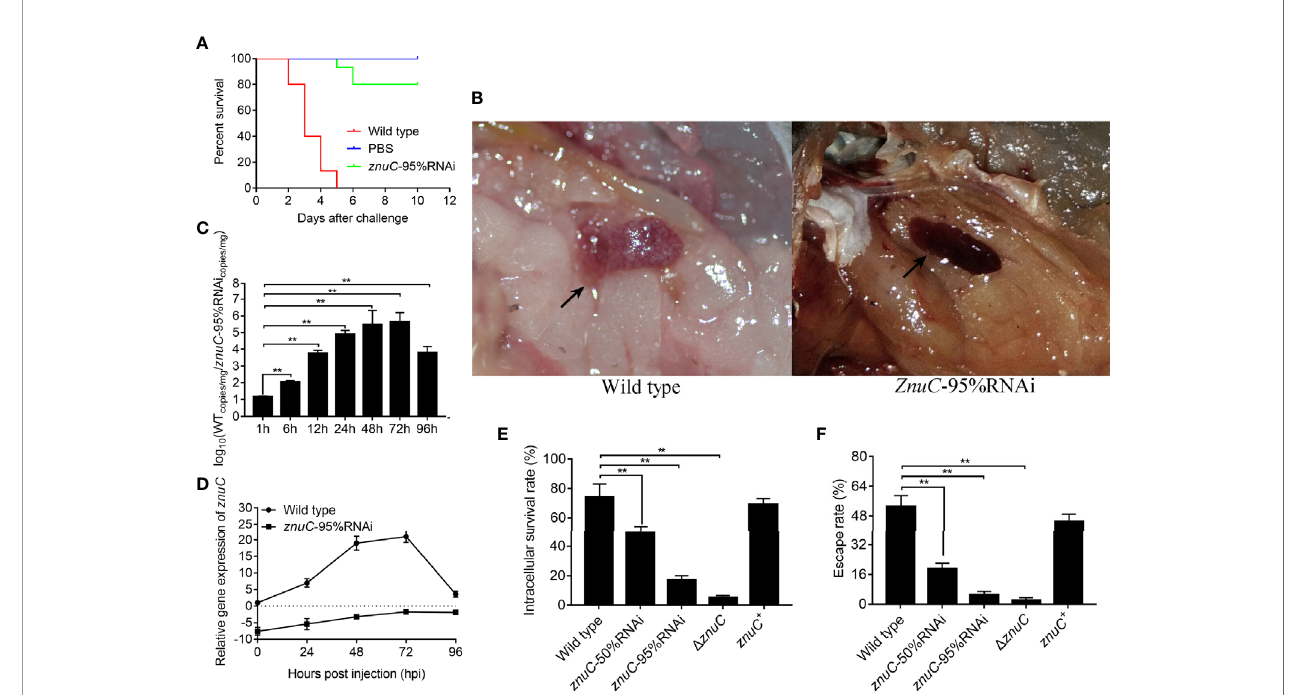
FIGURE 3 | ZnuC is essential for Pseudomonas plecoglossicida virulence. (A) To assess the importance of znuC to P. plecoglossicida pathogenesis, Epinephelus coioides were infected with P. plecoglossicida wild type and znuC -95%RNAi. Amounts of E. coioides that survived after infection with the indicated strains were compared (n=3). (B) The E. coioides infected with P. plecoglossicida were dissected and observed at 96 hpi. Symptoms of E. coioides spleen after infection with P. plecoglossicida were compared. (C) The bacterial burdens of P. plecoglossicida wild type and znuC -95%RNAi in E. coioides spleen were measured by quantitative real time PCR (qRT-PCR) at 1, 6, 12, 24, 48, 72, and 96 hpi. Temporal dynamic distribution of P. plecoglossicida in E. coioides spleen were compared. (D) To determine whether the reduced bacterial burdens of the znuC -95%RNAi in E. coioides spleen was due to the stable low expression of znuC , we compared the expression of znuC in P. plecoglossicida wild type and znuC -95%RNAi during the infection at 0, 24, 48, 72 and 96 hpi. (E, F) Given our observation of increased Zinc (Zn) uptake in the Golgi apparatus of E. coioides macrophages after infection, we sought to validate whether the znuC in P. plecoglossicida is important for intracellular survival. The intracellular viability and immune escape of wild type, znuC -50%RNAi, znuC -95%RNAi, D znuC and znuC + strains were compared in E. coioides macrophages. Values are mean ± SD (n = 3, ** P <